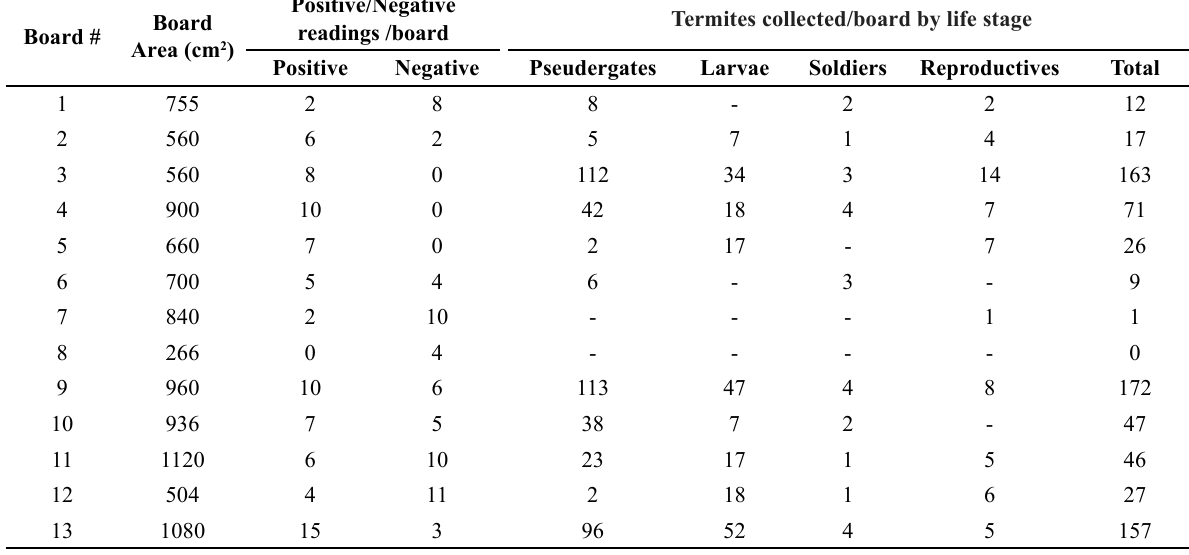
Table 1. Ability of the Termatrac™ to reliably detect C. brevis in different boards in relation to the number of life stages detected by subsequent destructive